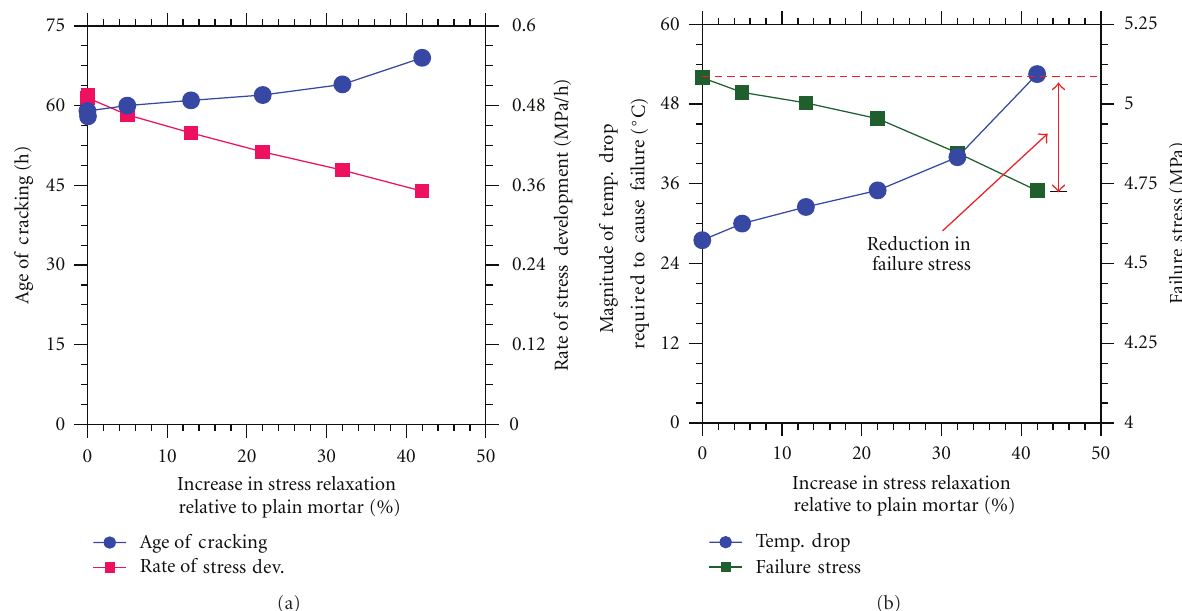
Figure 13: Influence of stress relaxation on (a) the stress development and the age of cracking, and (b) the magnitude of temperature reduction and the average stress at failure in the dual ring